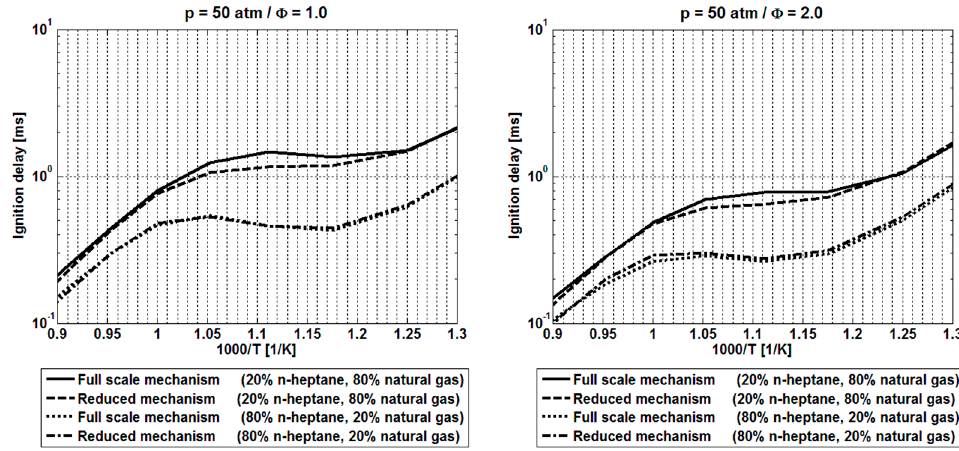
Figure 6. Comparison of ignition delay calculations for dual fuel mixtures. The full scale dual fuel mechanism is compared to the reduced mechanism.